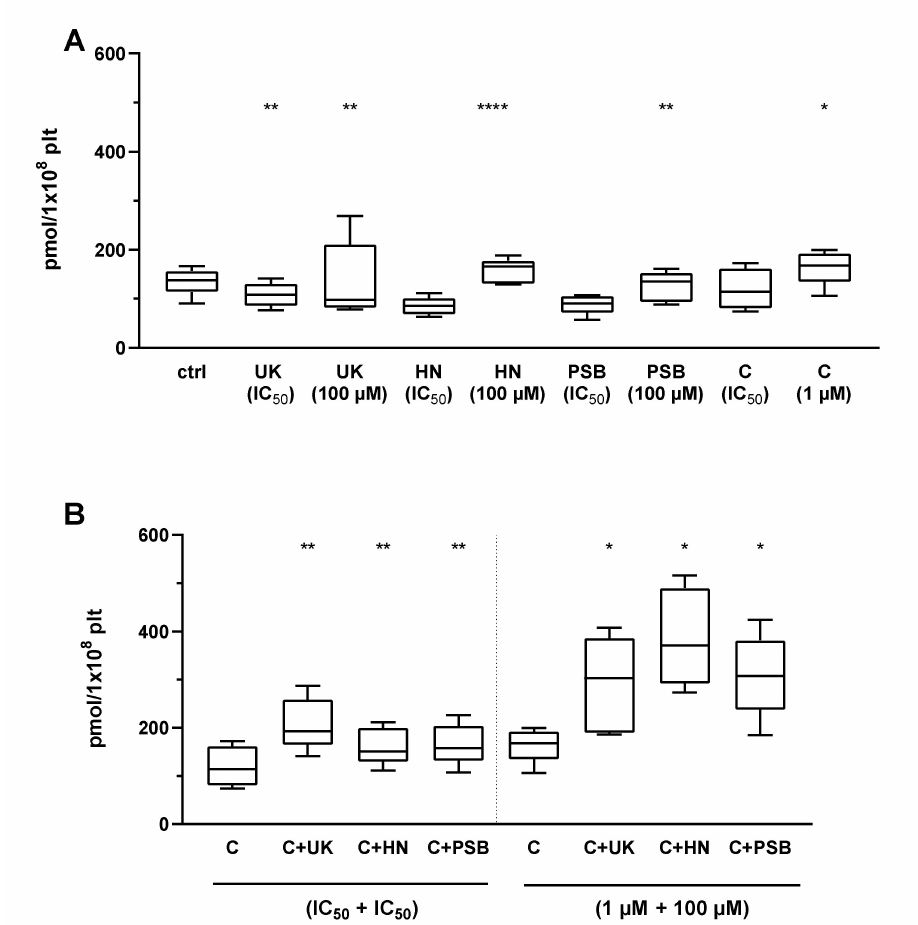
Figure 7. AR agonists strengthen the P2Y 12 inhibitory e ff ect on platelet reactivity as measured by measured by cAMP formation in ADP- activated platelets ( n = 5). Figures present data on AR agonist impact on platelets in comparison to platelets stimulated with 20 µ M ADP (ctrl) ( A ), platelets antagonised with P2Y 12 inhibitor: cangrelor ( B ). Data are shown as median, interquartile range (box), and minimum and maximum values (whiskers). cAMP level was measured in isolated platelets after activation with 20 µ M ADP. Samples were preincubated at 37 ◦ C for 3 min with AR agonist and cangrelor. Statistical significance estimated by one-way ANOVA for repeated measurements with the post hoc Bonferroni’s multiple comparisons test or Friedman’s test with Dunn’s correction for multiple comparisons (groups containing AR agonist are compared to control group with P2Y 12 inhibitor) (samples containing AR agonist are compared to control samples with P2Y 12 inhibitor within pertinent group). * p < 0.05, ** p < 0.01, **** p < 0.001. UK—UK423,097, HN—HE-NECA,